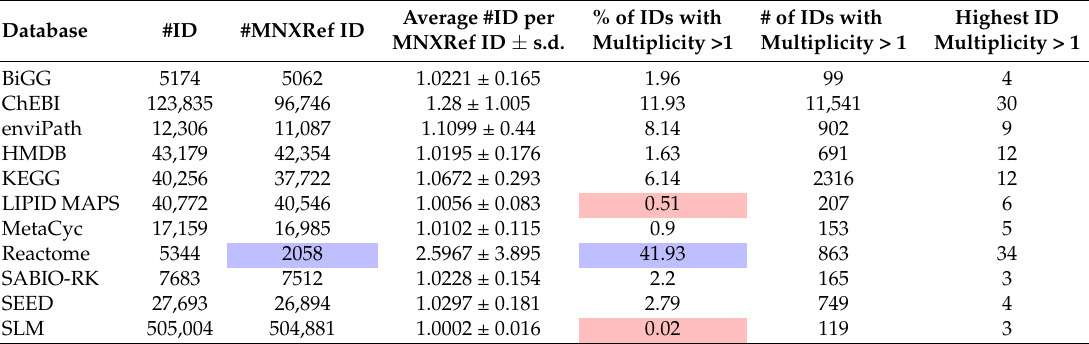
Table 4. Number of IDs (#ID) in each database, number of MNXRef IDs (#MNXRef ID) linking to each database, multiplicity of MNXRef IDs when mapping to IDs in the corresponding database, and average and highest number of MNXRef ID per database ID; s.d. stands for standard deviation. Blue boxes are used to highlight highest numbers, while red boxes are for lowest